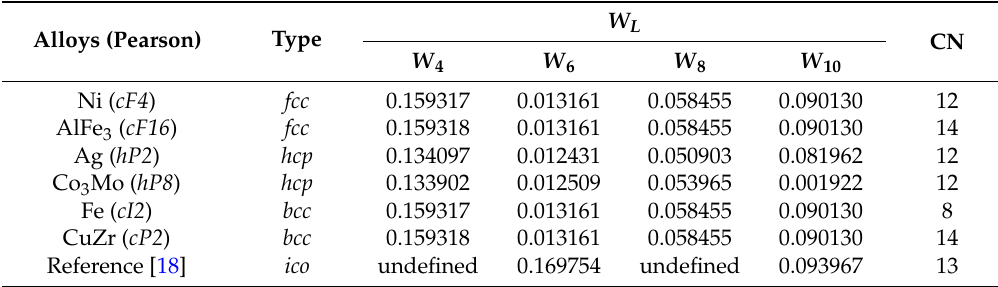
Table 1. Standard W L values for relative